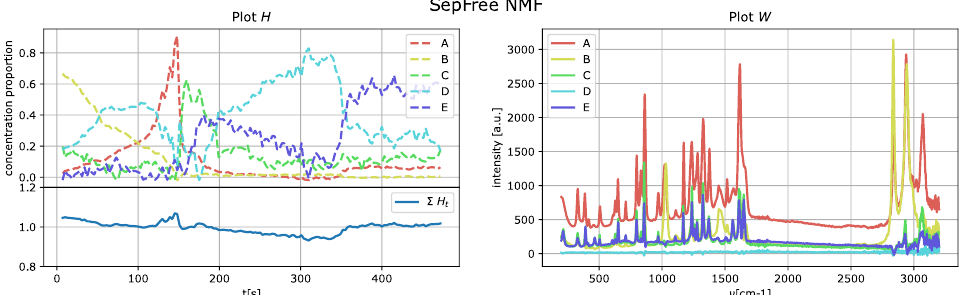
Figure 10. SepFree NMF NMF analysis of the crystallization Raman spectrum with r = 5. Minimal memory effect is det ( S ) =